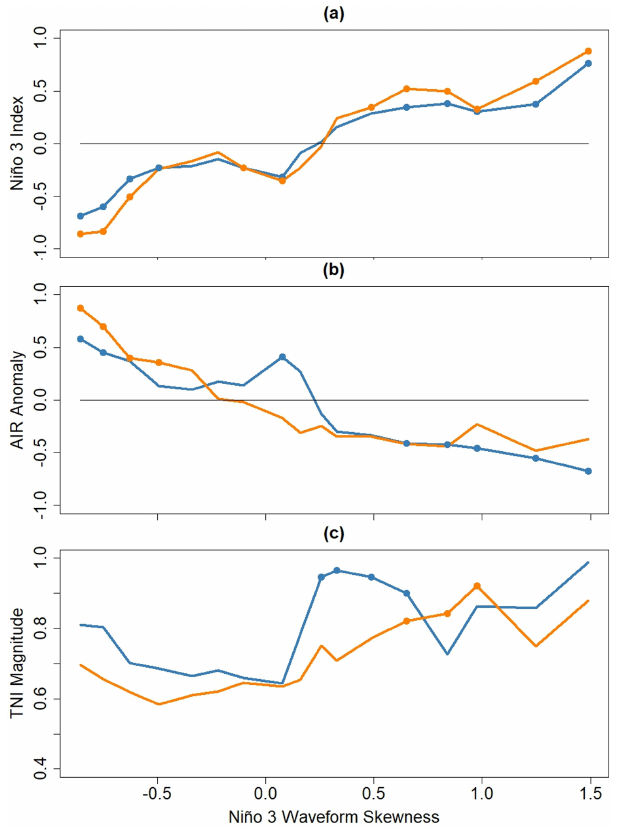
Figure 11. Composite mean (a) Niño 3 index, (b) AIR anomaly, and (c) TNI magnitude as a function of Niño 3 waveform skewness. Dots indicate statistical significance at the 5% level.